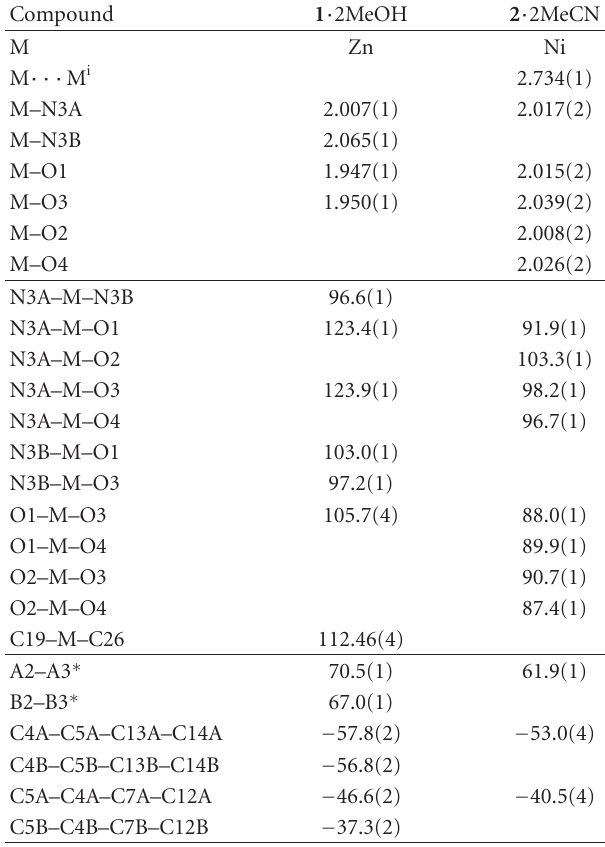
∗ Angle between the mean-planes of the named phenyl rings (see Figure 1). Symmetry codes: (i) 1 / 2 − x , 1 / 2 − y , 1 −